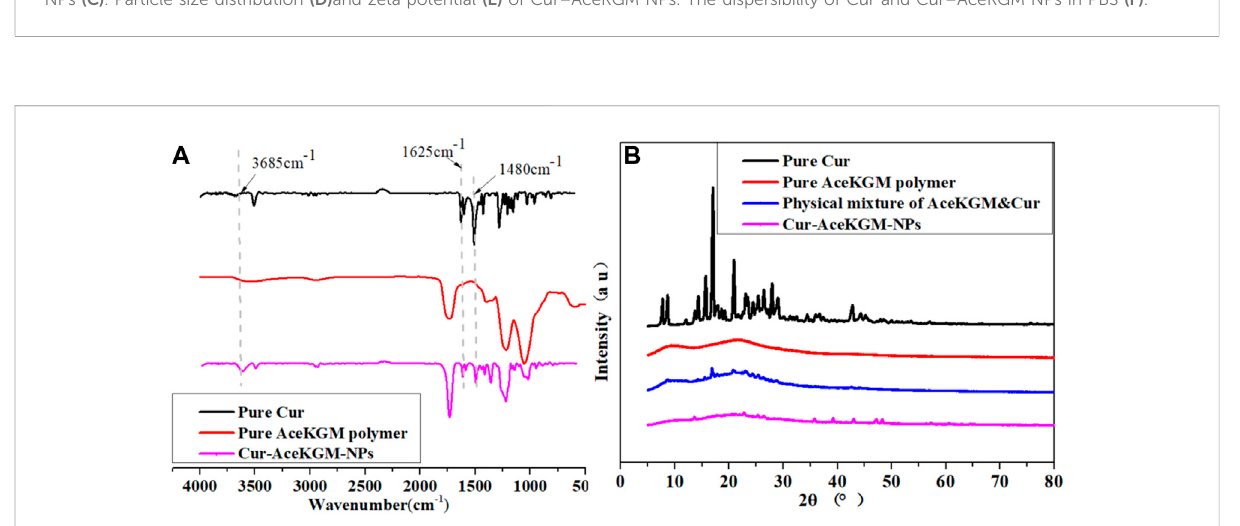
FIGURE 2 FT-IR (A) and XRD (B) spectra of pure Cur, pure AceKGM nanoparticles, physical mixture of AceKGM and Cur, and Cur – AceKGM